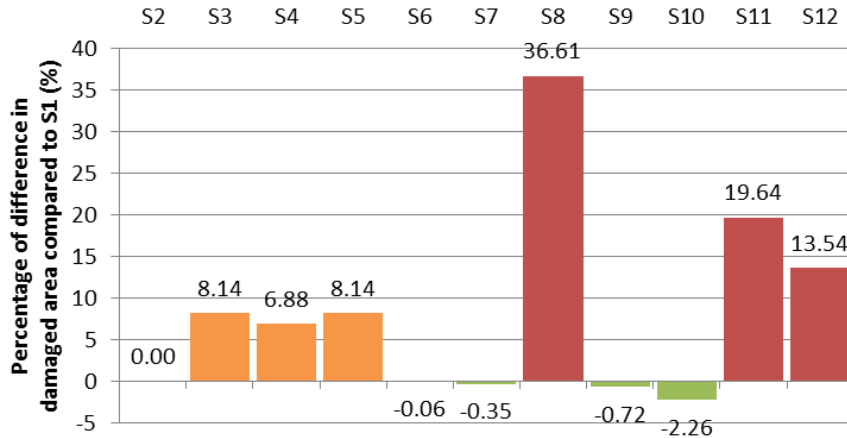
Figure 10. Deviation of total damaged area of all scenarios in relation to S1 ( = 0).